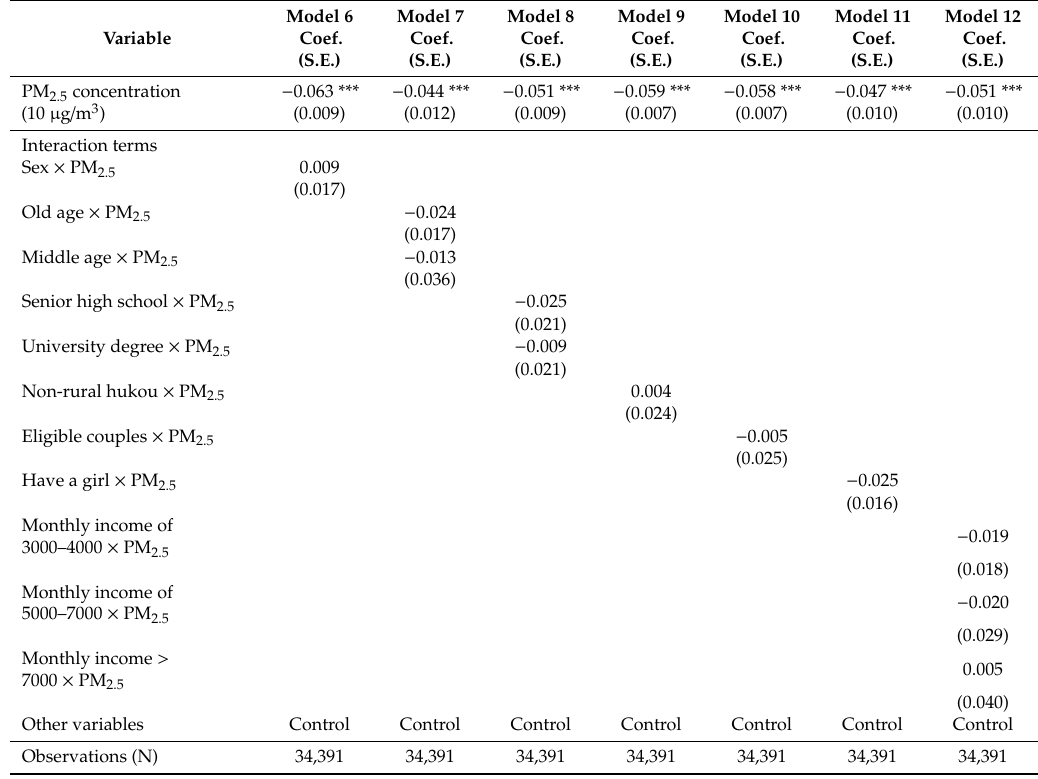
Table 3. Di ff erences in the influence of smog on the second birth intention of the floating population across individual-level variables. Variable